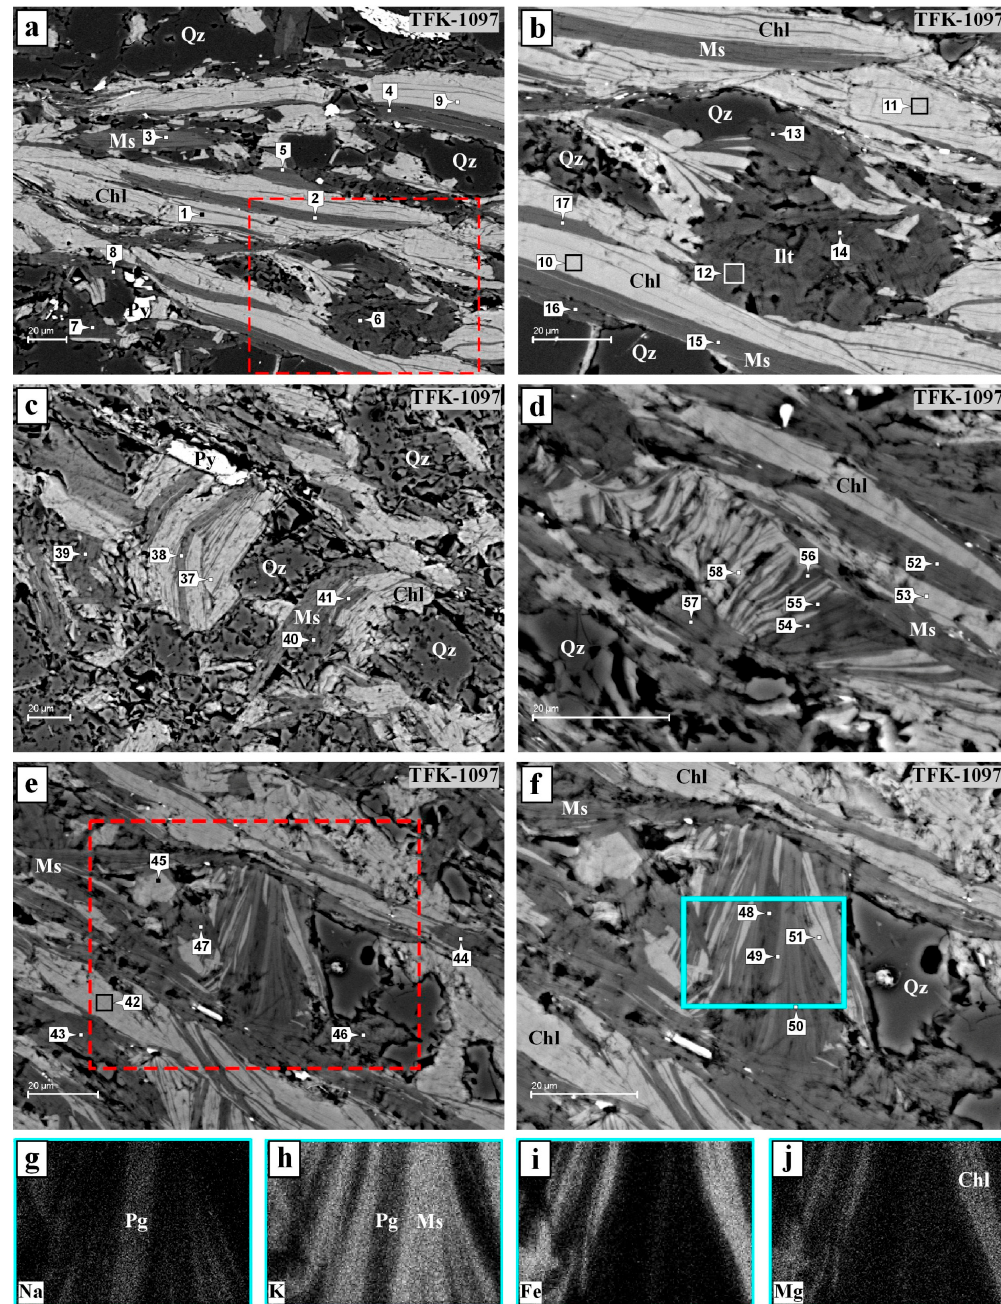
Figure 4. SEM-BSE photomicrographs of the Precambrian phyllitic slate with locations of some analyzed points and areas (black rectangulars). ( a , b ) Coarse-grained CMS oriented their long axes along the bedding planes and post-metamorphic illite occurrences, ( c , d ) The associations of CMS; both their stacking {001} planes are parallel to bedding planes and {001} are nearly perpendicular to bedding planes, i.e., along the schistosity or cleavage planes, ( e , f ) Highly disturbed white mica-rich CMS between shear zones in which {001} planes of CMS are nearly perpendicular to bedding plane and also to the shear band planes, ( g – j ) X-ray elementary maps (Na, K, Fe, Mg) of the CMS displaying the chemical differences of chlorite, white K- and Na-K mica/paragonite. Chl = Chlorite, Ilt = Illite, Ms = Muscovite, Pg = Paragonite, Py = Pyrite, Qz =